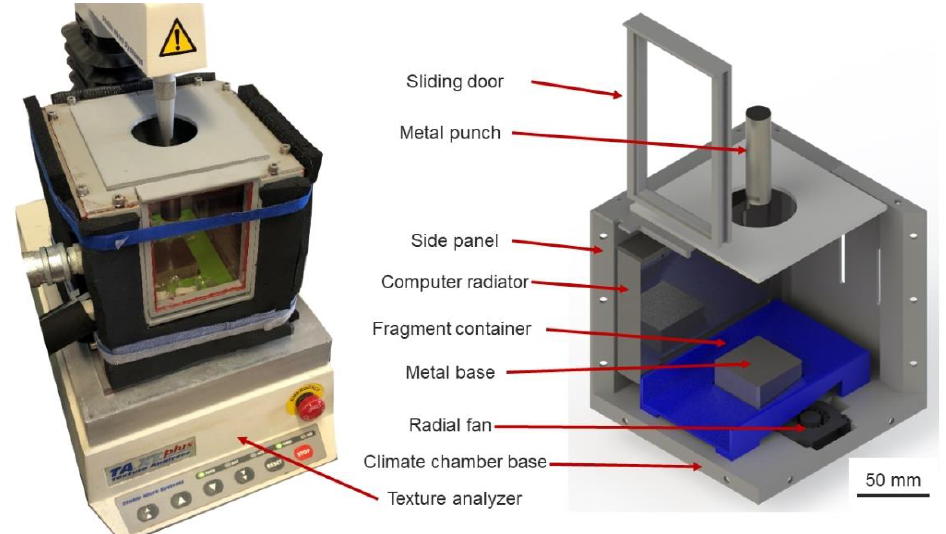
Figure 1. Texture Analyzer system equipped with a climate chamber: ( Left ) Climate chamber coupled with Texture Analyzer; ( Right ) CAD design.